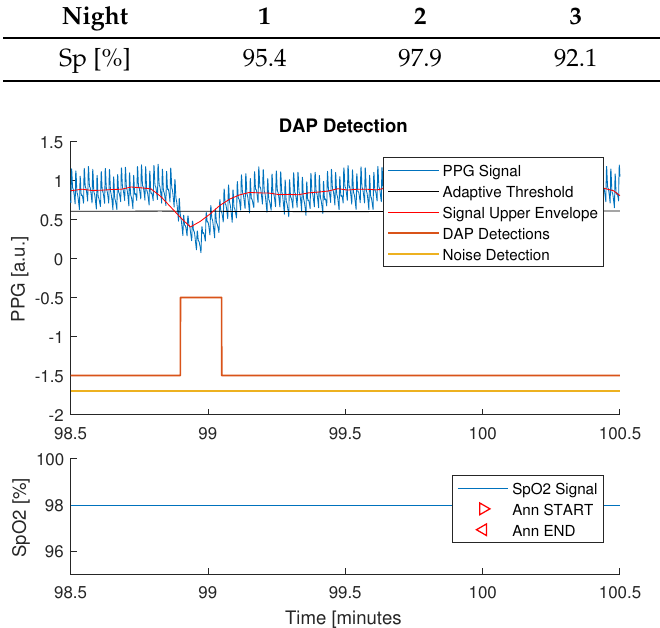
Figure 7. The DAP detection method is applied to a PPG